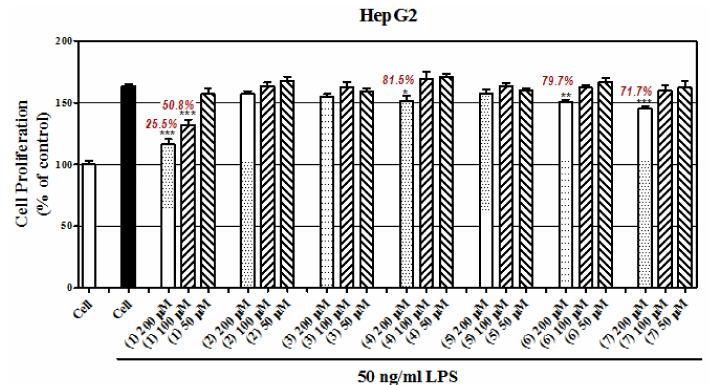
Figure 4. Effect of compounds on inhibition of lipopolysaccharide (LPS)-induced hepatomacell proliferation of SMMC-7721 cells ( A ) and HepG2 cells ( B ). (* denotes p < 0.05; ** denotes p < 0.01; *** denotes p < 0.001, vs. LPS-induced hepatoma cells).